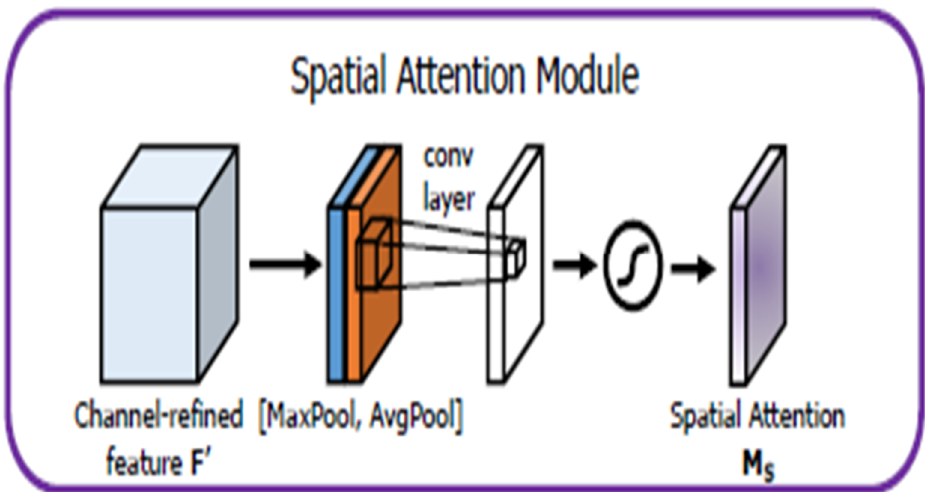
Figure 4. Illustration of a spatial attention module.